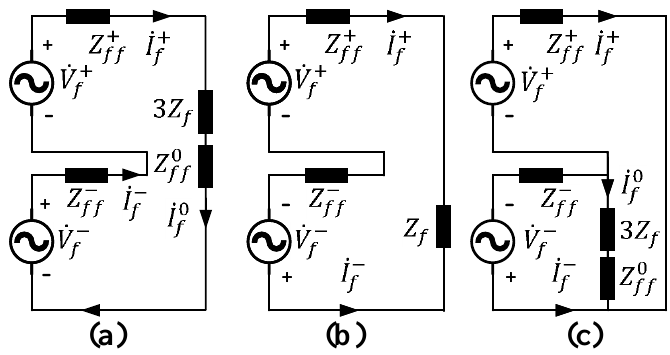
Figure 1. Boundary conditions for faulted networks: ( a ) single-phase-to-ground fault; ( b ) two-phase fault; ( c ) two-phase-to-ground